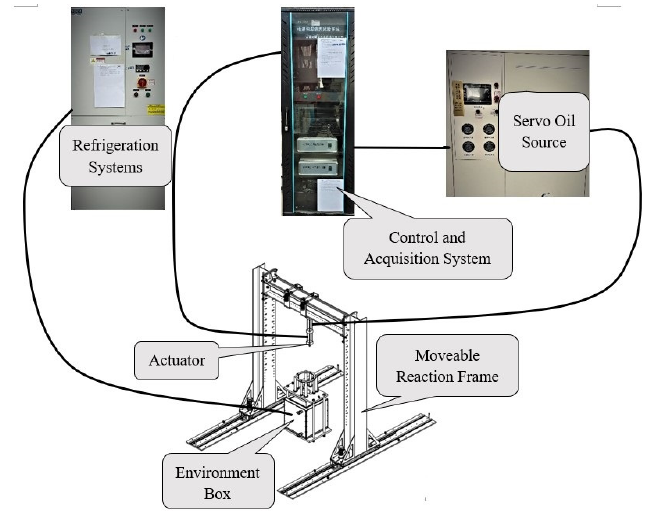
Figure 3. Schematic diagram of the test equipment.